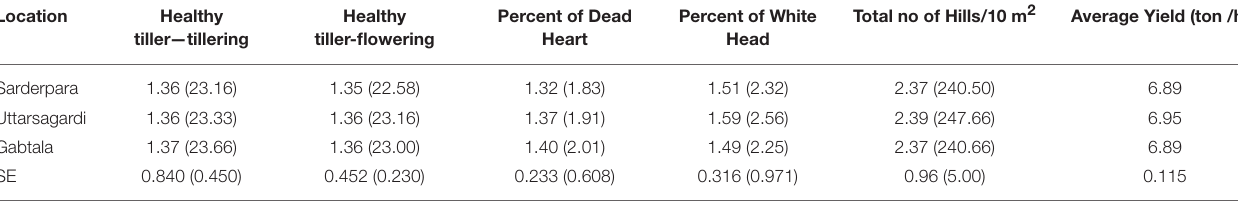
TABLE 2 | Effect of location on tillers, hills, dead heart, white head, and yield of rice crops in 2011-12. Location